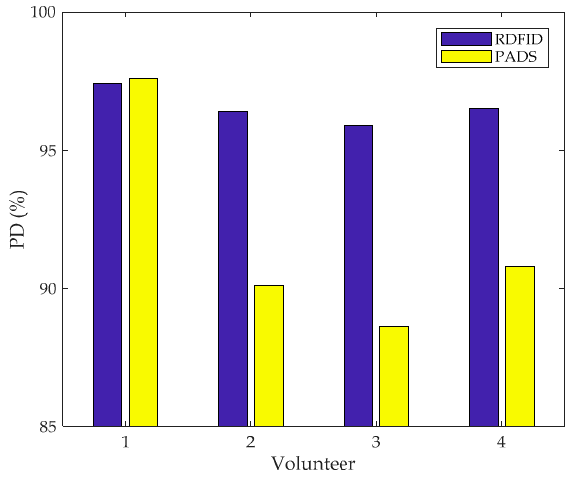
Figure 9. PD of human detection of different people.